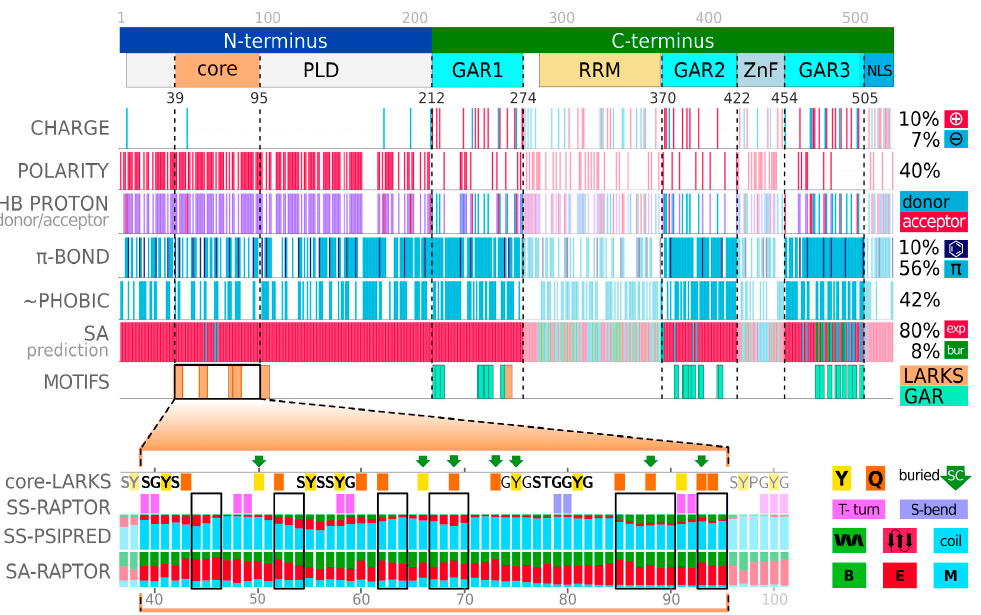
Figure 5. Physicochemical and structural properties of FUS. The various characteristics are shown along the protein-sequence split on the N-terminus (blue) and C-terminus (green). The full-length N-terminus corresponds to a highly polar prion-like domain (PLD in gray). The PLD contains a core region (residues 39–95 in orange), in which multiple LARKS motifs were detected (orange bars in the MOTIFS row) and evidenced to form fibrils in a solid state. The C-terminus contains two well-folded domains detected by Pfam search (RRM in yellow, ZnF in gray), and three glycine–arginine-rich (GAR in cyan) regions. All components of the C-terminus are known to have a functional role in RNA binding. The following rows show the physicochemical patterning along the full-length FUS sequence, including charge (positive (magenta), negative (blue)), polarity, donor (blue)/acceptor (magenta)/both (purple) of side-chain proton for hydrogen bonding, π -electron-containing systems (blue), with separation of aromatic ones (dark blue), hydrophobicity (blue), predicted solvent accessibility (SA) in 3-letter notation (exposed (red), buried (green), medium (blue)). The zoom of the PLD core is shown at the bottom panel, where the SS and SA rows contain the predicted probabilities of secondary structure (helix (green), strand (red), coil (blue)) and solvent accessibility. The green arrows indicate the side chains buried in the fibril core, while the black frames highlight segments that form strands of a cross- 𝛽 motif [37].